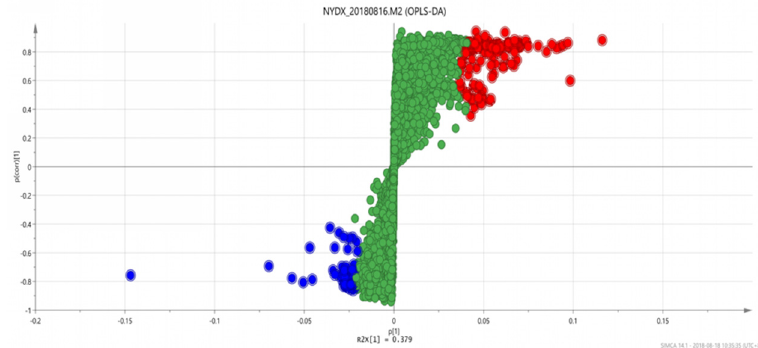
Figure 11. OPLS-DAS-plot diagram between group 1 and group 2.